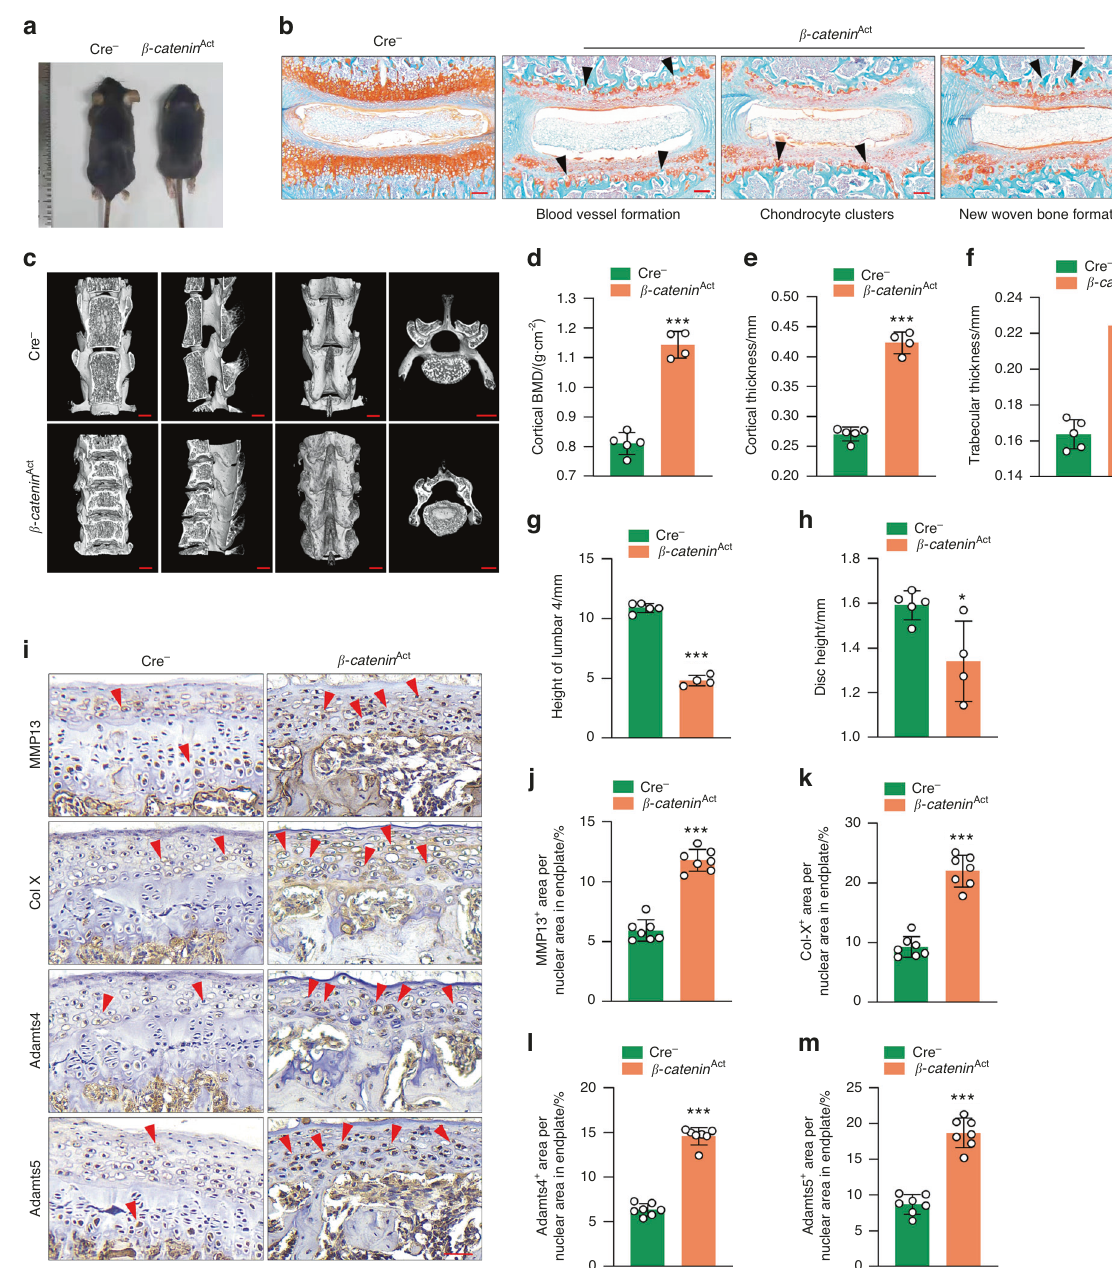
Fig. 2 Activation of β -catenin signaling leads to intervertebral disc degeneration and vertebral sclerosis. a Representative image showing the size of 3-month-old β -catenin Act mice and their Cre − littermates (scale bar 100 μ m). b Representative Safranin O/Fast Green staining of disc tissue in 5-week-old β -catenin Act mice and their Cre − littermates (scale bar 100 μ m). Arrowheads indicate cell cluster formation, blood vessel invasion and new woven bone formation ( n = 7). c Representative μ CT images of vertebral bone of β -catenin Act mice and their Cre − littermates (scale bar 2.5 mm). d – f Histomorphometric analysis to measure cortical bone mineral density (BMD) ( d ), cortical thickness ( e ) and trabecular thickness ( f ) in 3-month-old β -catenin Act mice and their Cre − littermates (Cre − : n = 5, β -catenin Act : n = 4). g , h The height of the 4th lumbar vertebra ( g ) and the disc height ( h ) in 3-month-old β -catenin Act mice and their Cre − littermates (Cre − : n = 5, β -catenin Act : n = 4). i – m Representative IHC images ( i ) (scale bar 20 μ m) of MMP13 + ( j ), Col-X + ( k ), Adamts4 + ( l ) and Adamts5 + ( m ) areas in the endplate of 3-month-old β -catenin Act mice and their Cre − littermates. Arrowheads indicate positive cells by IHC ( n = 7). * P < 0.05; ** P < 0.01; *** P < 0.001. Data are represented as the mean ± SD. Two-tailed unpaired Student ’ s t test analysis ( d – h , j – m chromatin immunoprecipitation (ChIP) assay using HEK293T cells treated with IL-1 β or transfected with the Tcf7 plasmid. ChIP-enriched DNA was subjected to qPCR analysis. We found that TCF7 binds to the − 1 194/ − 1 183 and − 556/ − 545 regions of the